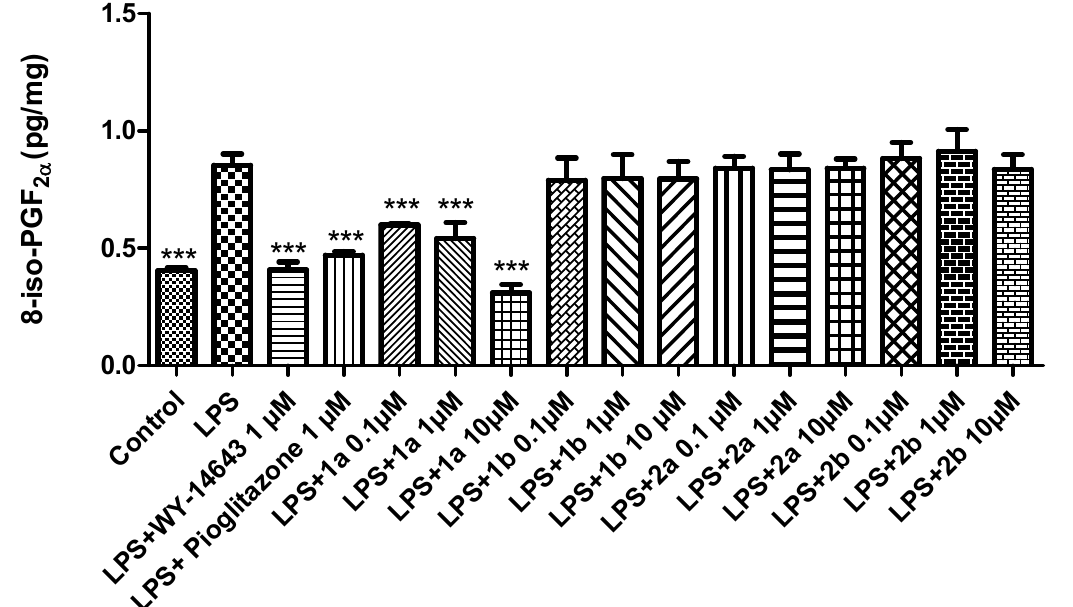
Figure 6. The effects of WY-14643 (1 µ M), pioglitazone (1 µ M), and 1a-b and 2a-b (0.1–10 µ M), on the LPS-induced production of 8-iso-PGF 2 α (pg/mg) in rat liver, ex vivo. Data were reported as means ± SEM. The results were analyzed by analysis of variance (ANOVA) followed by the Newman–Keuls post-hoc test. ANOVA, p < 0.0001; post-hoc *** p < 0.001 vs. LPS-treated group.